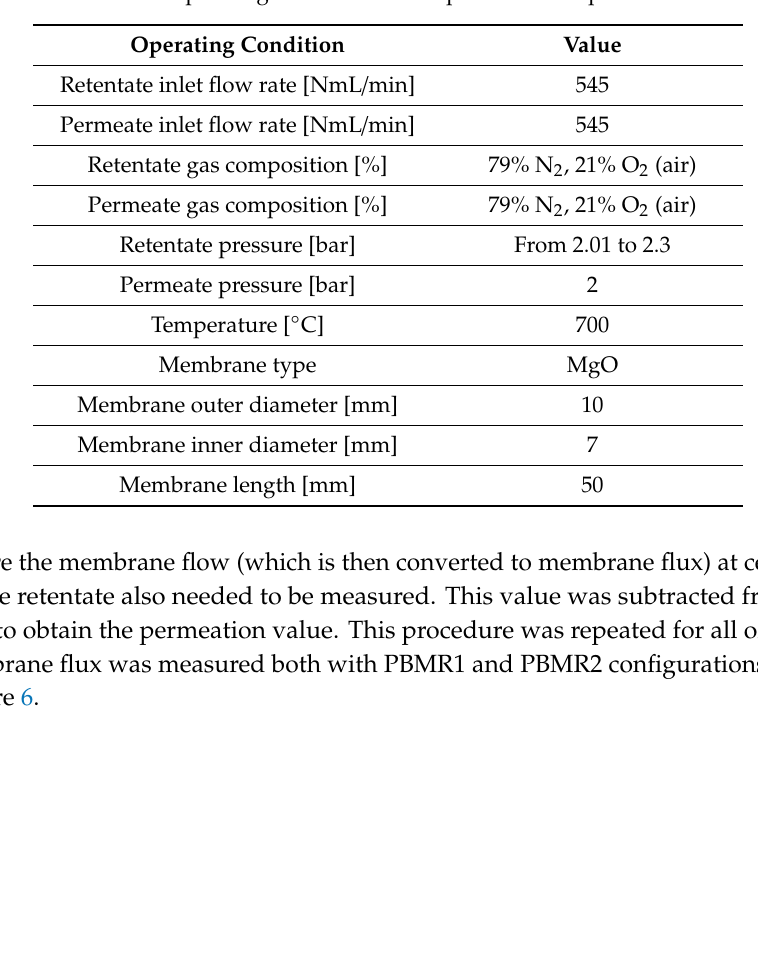
Table 4. Operating conditions of the permeation